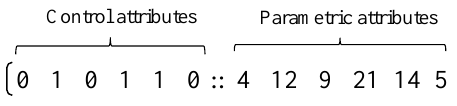
Figure 3. An example of the S3PSO particle